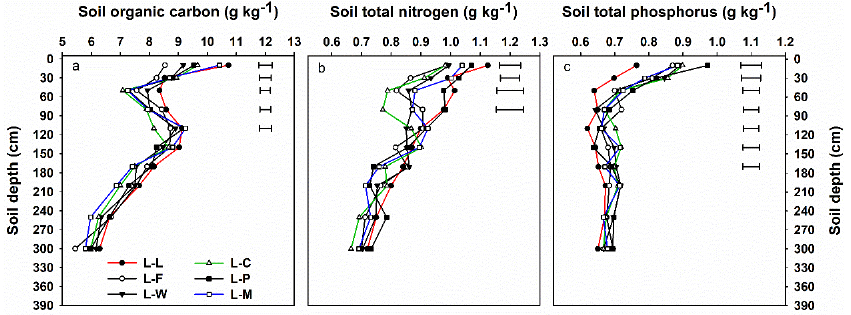
Figure 3. Soil organic carbon ( a ), total nitrogen ( b ), and total phosphorus ( c ) after lucerne-to-crop conversion in October 2018. Horizontal bars denote Fisher’s protected least significant difference at p ≤ 0.05. Treatment abbreviations are defined in Table 1.